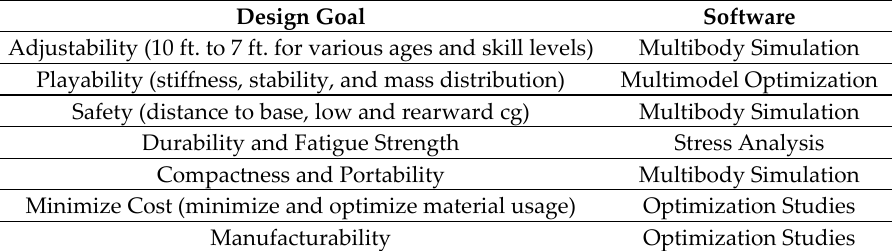
Table 1. Portable basketball hoop system design